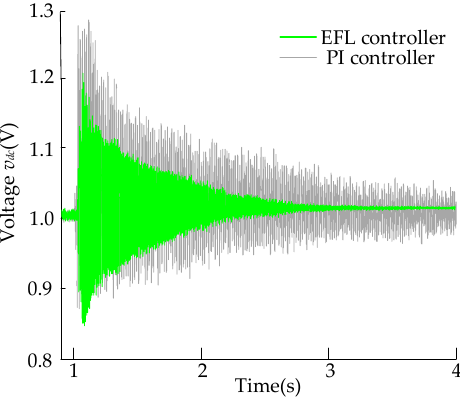
Figure 7. DC-link voltage ( v dc ) at a wind speed of 8 m/s and a series-compensation of 70%.